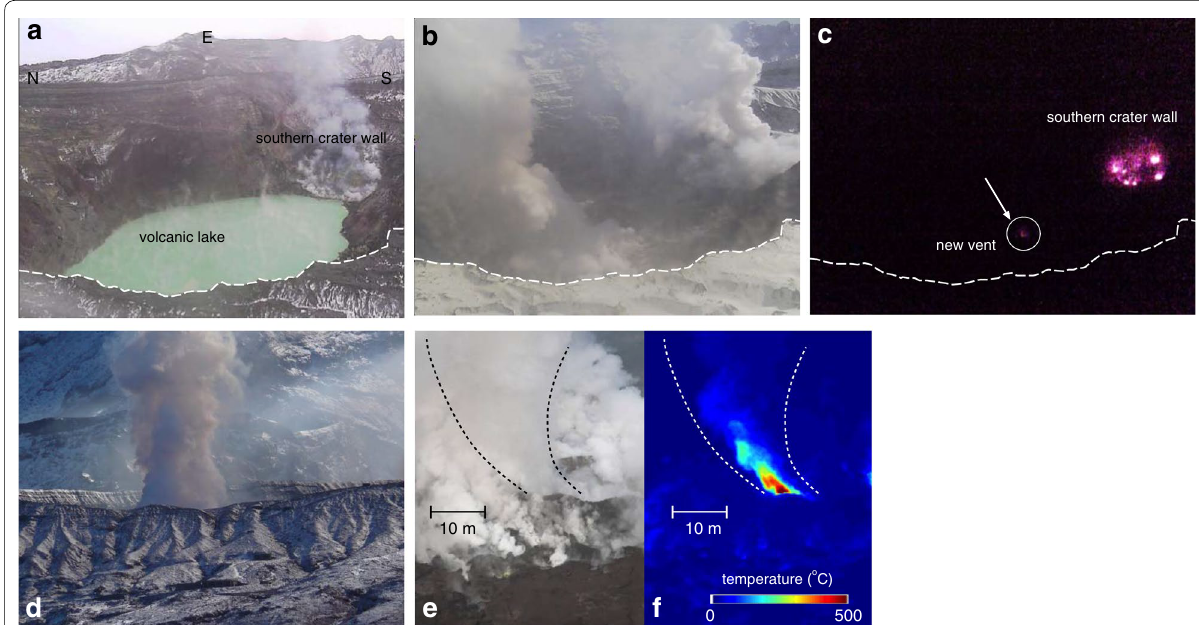
Fig. 2 Snapshots of the active crater from the west and southwest rim. a A volcanic lake was observed inside the Nakadake crater on 20 January 2013. A fumarolic region behind the lake (right-hand side of the image) was located on the southern crater wall. The orientation of the image is indicated by N, E, and S (see Fig. 1c). b On 25 December 2013, water was no longer present in the crater. c A new vent (indicated by the white circle) glows at the crater floor, similar to the southern crater wall (2 January 2014). Note that brightness, contrast, and sharpness of this picture have been adjusted in order to emphasize the glow. d The ashy plume was from the center of the crater (23 January 2014). This photograph was taken from 3 km west of the crater. e , f Visible and corresponding infrared thermal images after ash–gas emissions on 13 January 2014. High-temperature ( > 550 ◦ C ) volcanic gas with a minor amount of ash particles was emitted from a vent at the crater